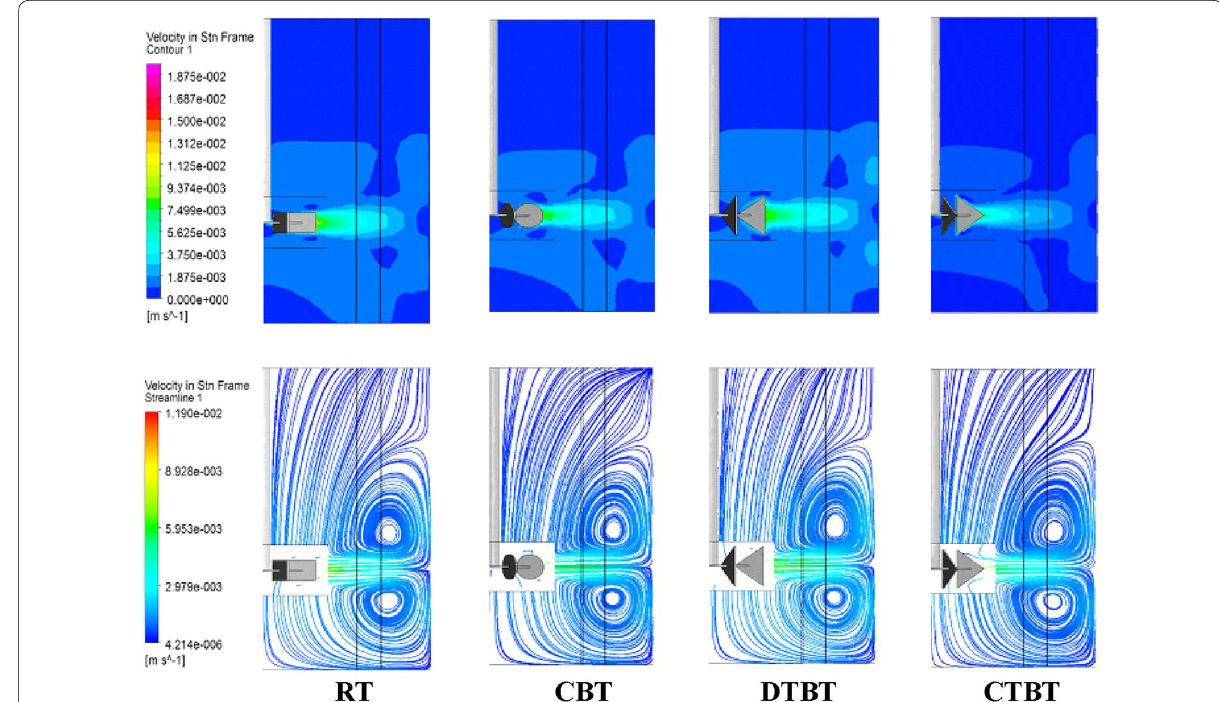
Figure 6 Flow fields for different agitator’s types of baffled tanks Re